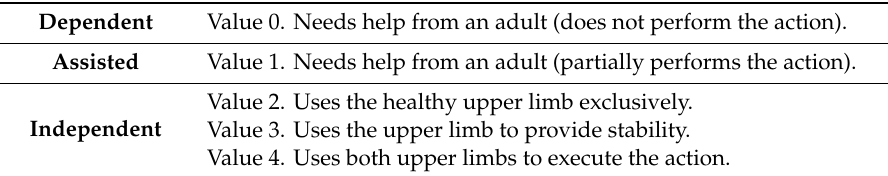
Table 2. Description of the functionality